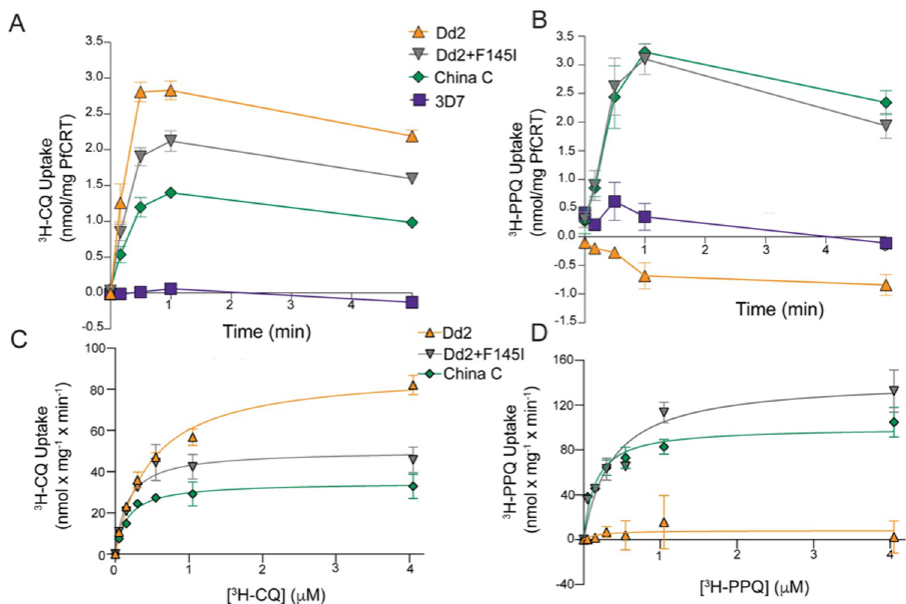
Fig 2. Functional characterization illustrates distinct CQ and PPQ transport properties for the China C PfCRT protein. ( A, B ) Time course of ( A ) 93 nM 3 H-CQ and ( B ) 75 nM 3 H-PPQ uptake measured with proteoliposomes containing the indicated PfCRT variants. Data are means ± SEM. N = 4. ( C, D ) Kinetic characterization of ( C ) 3 H-CQ or ( D ) 3 H-PPQ uptake in proteoliposomes containing the indicated PfCRT isoforms. The initial rate of transport was measured for periods of 10 seconds using 3 H-CQ or 3 H-PPQ concentrations ranging from 0.05 to 4.05 μ M. Data were fitted to the Michaelis-Menten equation. K m and V max values are shown as means ± SEM ( S3 Table ). N = 3–4. Transport kinetics of Dd2 or 3D7 PfCRT for PPQ or 3D7 PfCRT for CQ were not determined due to low signal-to- noise ratios and negligible transport.